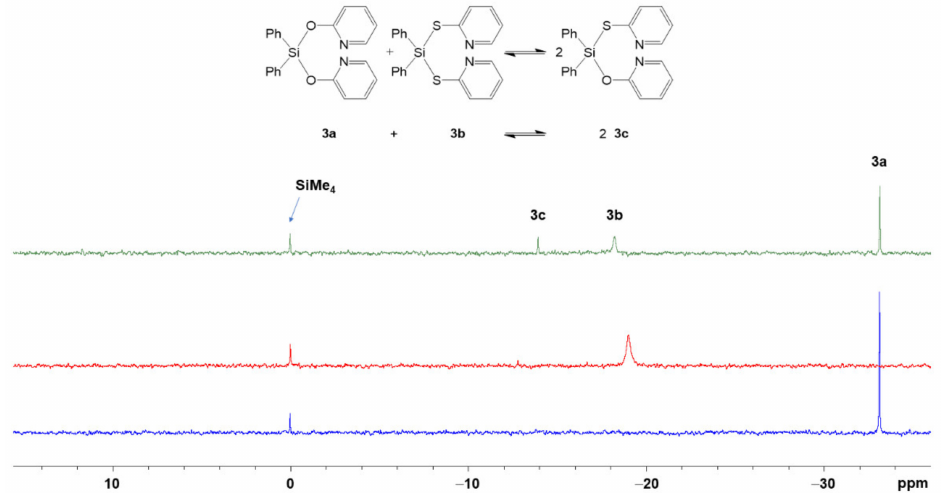
Figure 12. Stack plot of 29 Si{ 1 H} NMR spectra of (from bottom to top) a 0.38 M solution of 3a in CDCl 3 (blue trace), a 0.38 M solution of 3b in CDCl 3 (red trace) and of an equimolar mixture of these stock solutions (green trace) as well as a reaction scheme and signal assignment. We attribute the signal broadening for 3b to dynamic effects in the Si coordination sphere (cf. Section 3.2.3, the computational analyses of conformers and isomers of compound 2b